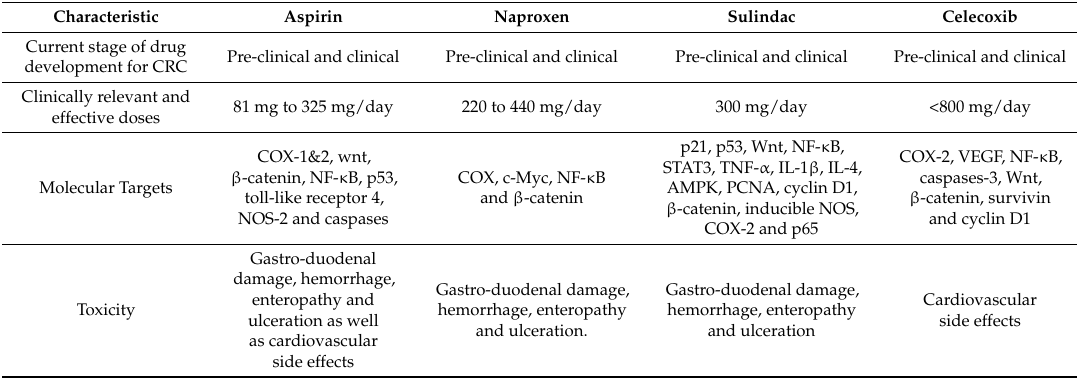
Table 1. Comparison and similarities among selected NSAIDs in drug development for CRC. Characteristic Aspirin Current stage of drug Pre-clinical and clinical Pre-clinical and clinical development for CRC Clinically relevant and effective